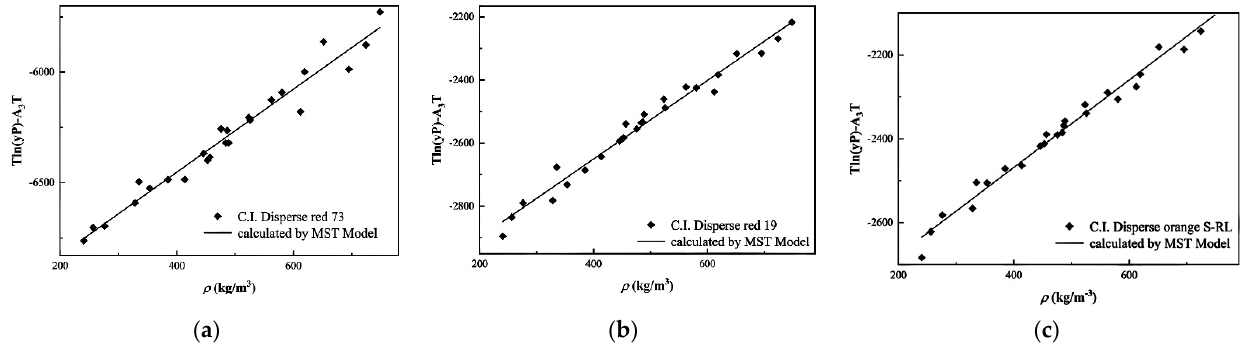
Figure 3. Solubilities in sc − CO 2 calculated by the MST model for ( a ) DR 73, ( b ) DR 19, ( c ) DO S–RL. As shown in Figure 4, solubility correlation lines of the three disperse dyes presented after K–J model correlation are similar to the fitting effect of the Chrastil model, which describes the positive correlation between the solubility values of dyestuffs and the density change in sc − CO 2 .